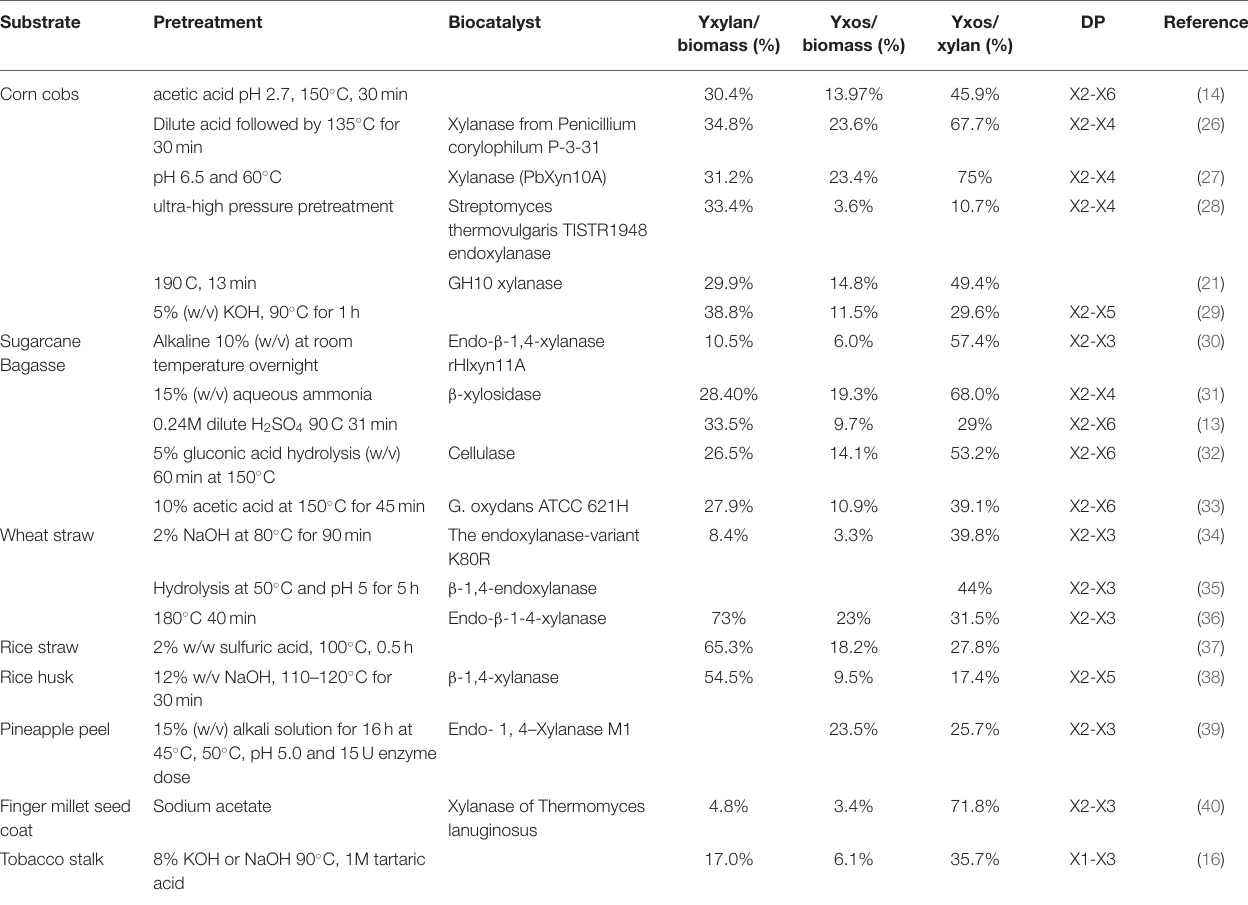
TABLE 1 | Summary of XOS preparation and yields in the most recent